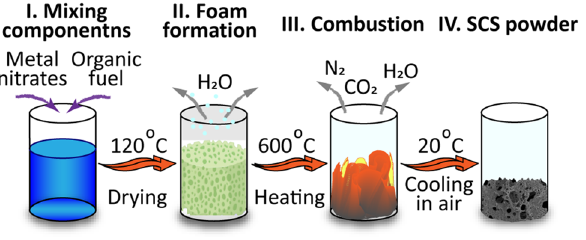
Figure 1. Simplified scheme of the SCS